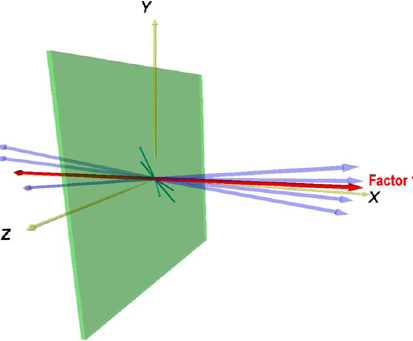
FIG. 4. (cid:1) Color (cid:2) Cast projections of the blue arrows onto the green screen perpendicular to factor 1.